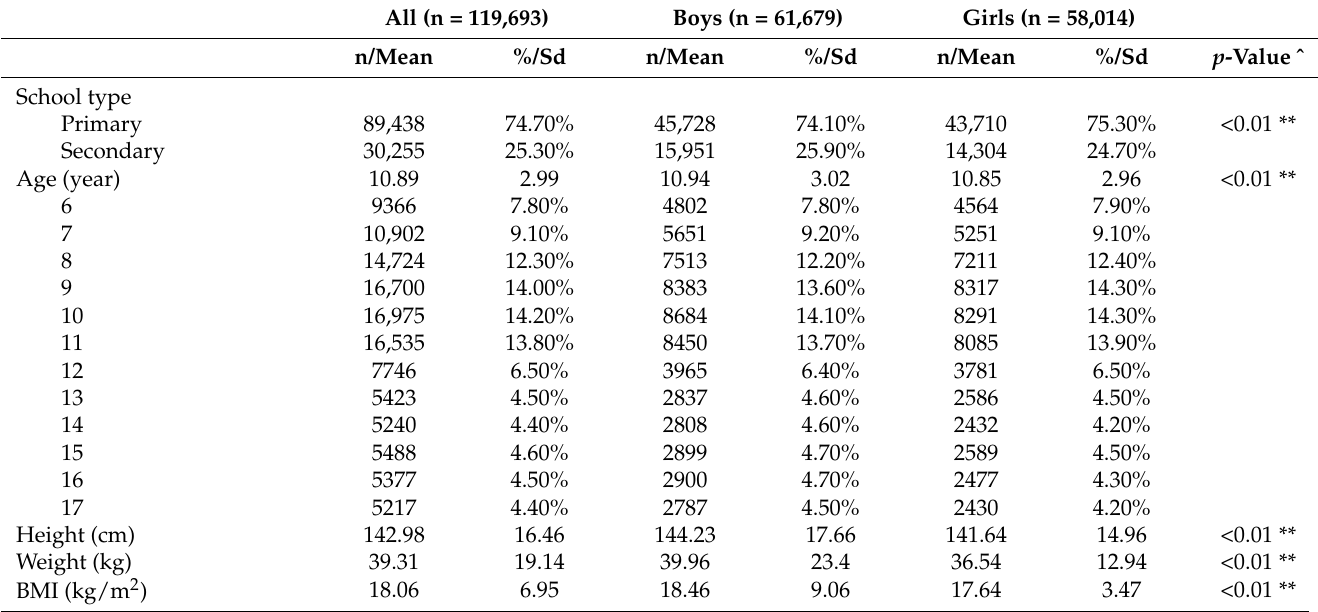
Table 1. Subjects’ descriptive